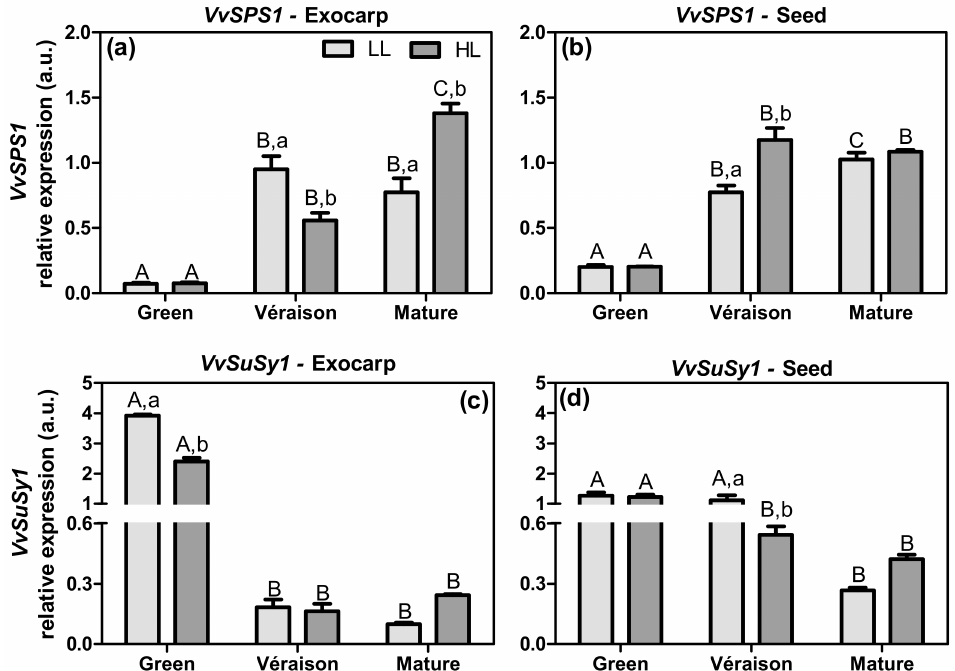
Figure 4. Relative expression in arbitrary units (a.u.) of transcripts of sucrose-phosphate synthase 1 ( VvSPS1 ) ( a , b ) and sucrose synthase ( VvSuSy1 ) gene ( c , d ) in exocarp and seeds, from berries grown at two distinct light microclimates (LL and HL), and at three developmental stages (green, v é raison , and mature), as determined by real-time qPCR. Expression levels are normalized to the mean expression of reference genes VvACT1 and VvGAPDH . Statistical analysis (two-way ANOVA, p ≤ 0.05, n = 3) was applied after data Log(X+1) transformation. Statistical notation: capital letters refer to differences between developmental stages for the same microclimate, and lowercase letters refer to differences between microclimates for each stage. When the letters are omitted, it means that the respective factor did not have a significant